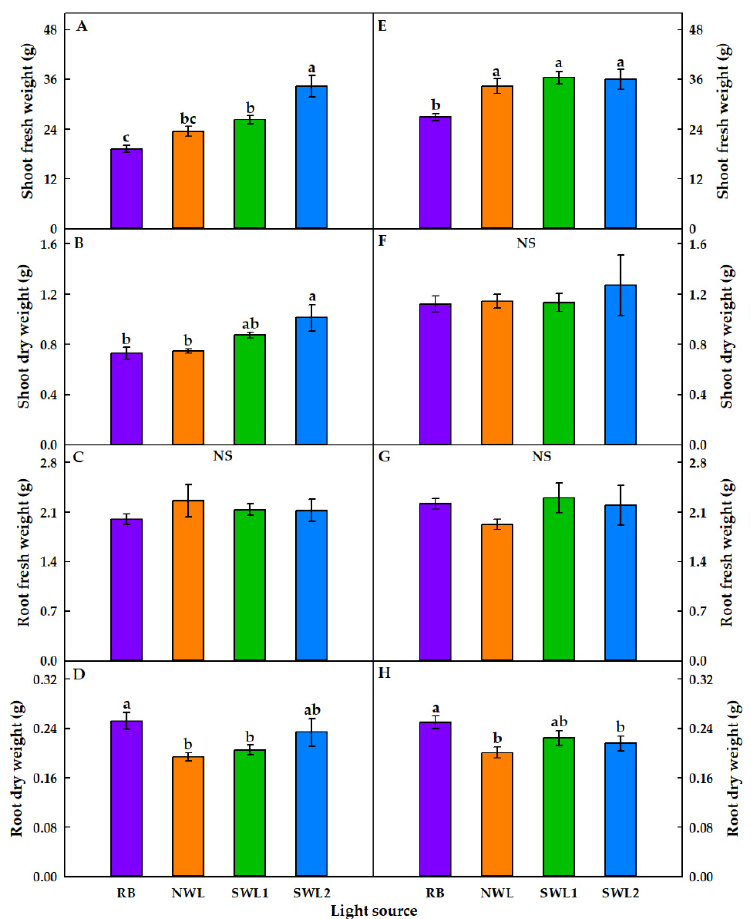
Figure 3. Shoot and root fresh and dry weights of butterhead lettuce ( A – D ) and romaine lettuce ( E – H ) plants grown under various light sources with the same electrical power after 4 weeks of transplanting. Different letters indicate significant difference at p < 0.05 ( n = 4).